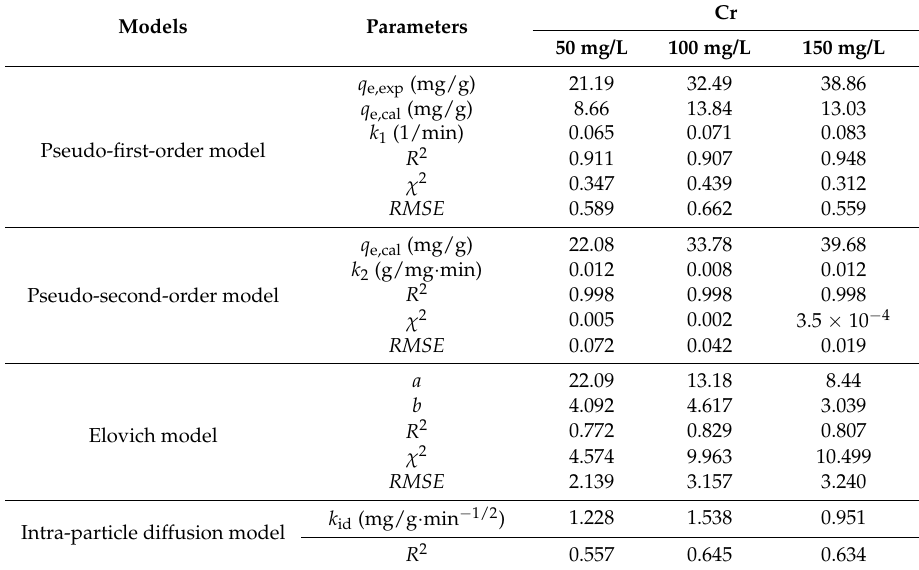
Table 1. Constants of four kinetic models for Cr adsorption onto Typha angustifolia activated carbon.